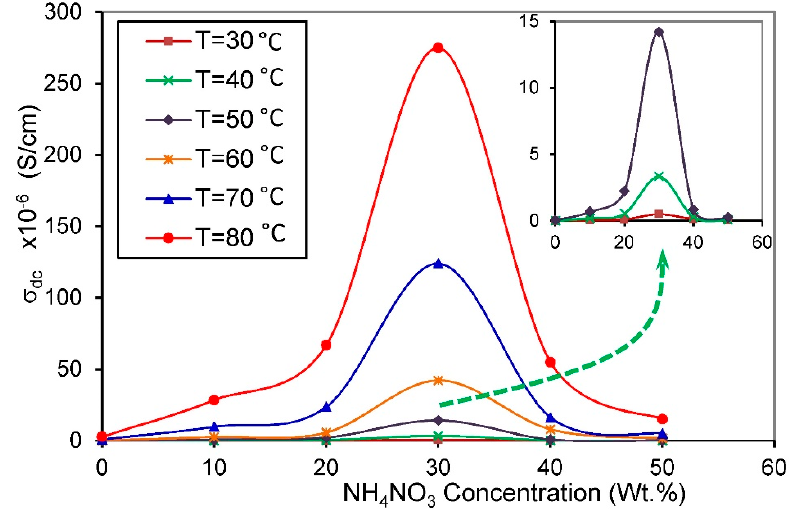
Figure 8. Conductance spectra for PVA/NH 4 NO 3 proton-conducting SPE films with different salt concentrations at various temperatures.